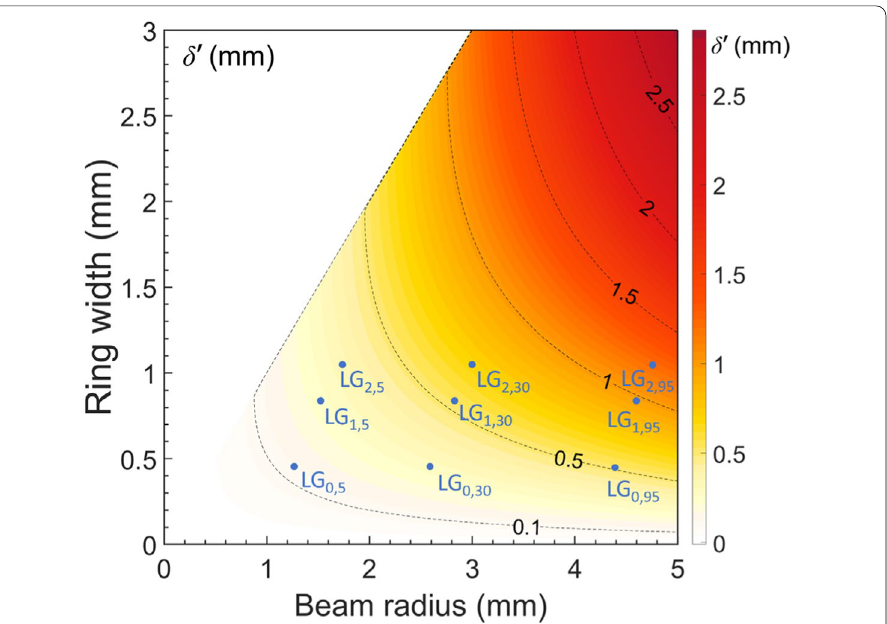
Fig. 4 Contour plot of the SA-induced focal point displacement δ ’ as a function of beam radius W p,m and ring width d p,m (with the f 33.9 mm lens =